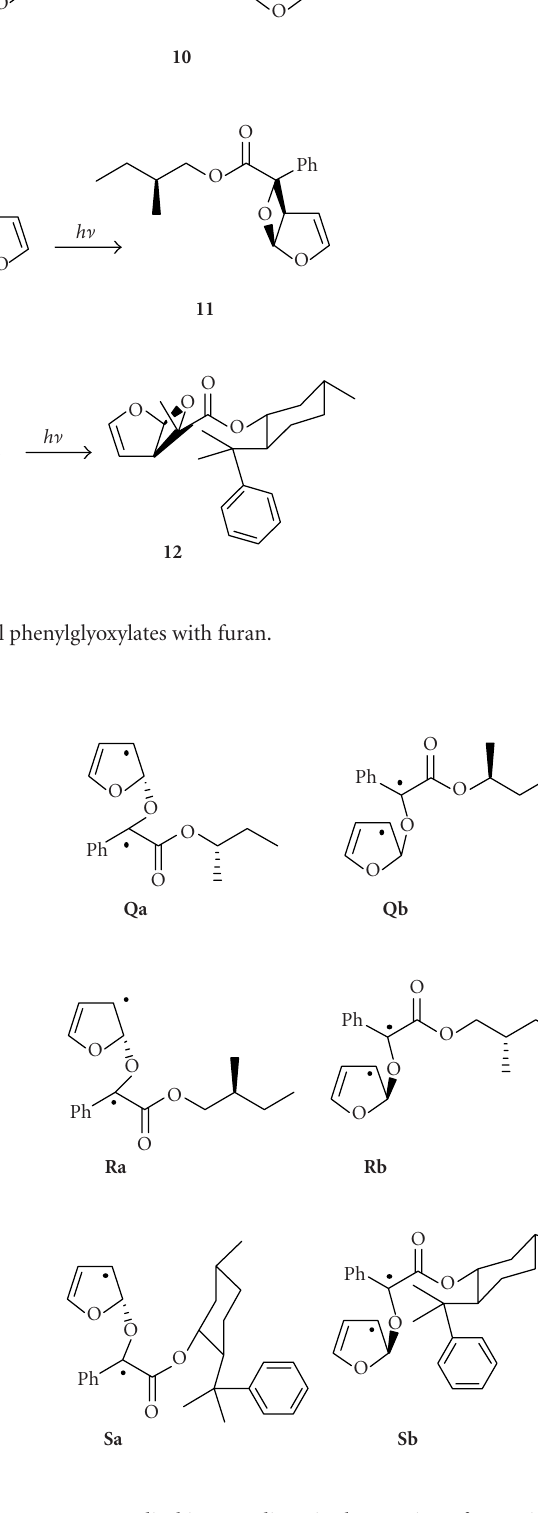
Figure 8: Radical intermediates in the reaction of 7–9 with